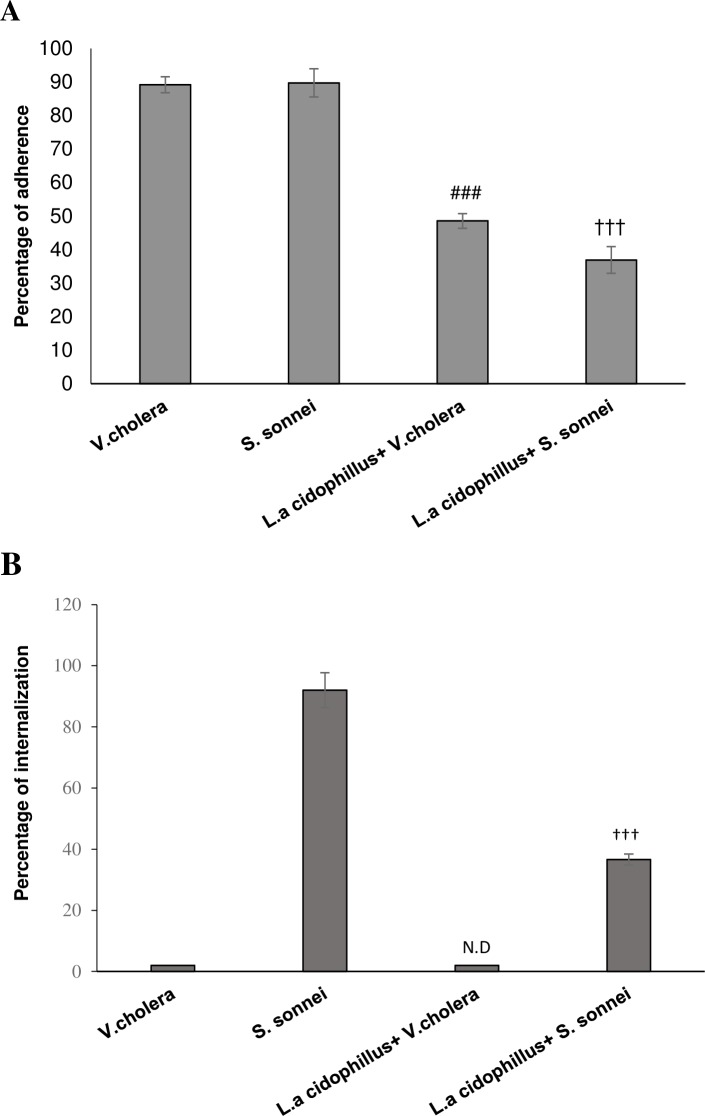
(A and B) Effect of pretreatment of L. acidophilus on its ability to inhibit V. colarae/ S. sonnei adherence and invasion to Caco-2 cells. ND means Not Detectable. Each value indicates the mean±SEM from three independent experiments and three replicates (n = 3). ###p < 0.001 significantly different of L.a+V.c+Caco-2 group from V.c+Caco-2 group. †††p < 0.001 significant difference between L.a+S.s+Caco-2 group and S.s+Caco-2 (by unpaired two-tailed Student’s t test). L.a: Lactobacillus acidophilus, V.c: Vibrio cholerae and S.s: Shigella sonnei.